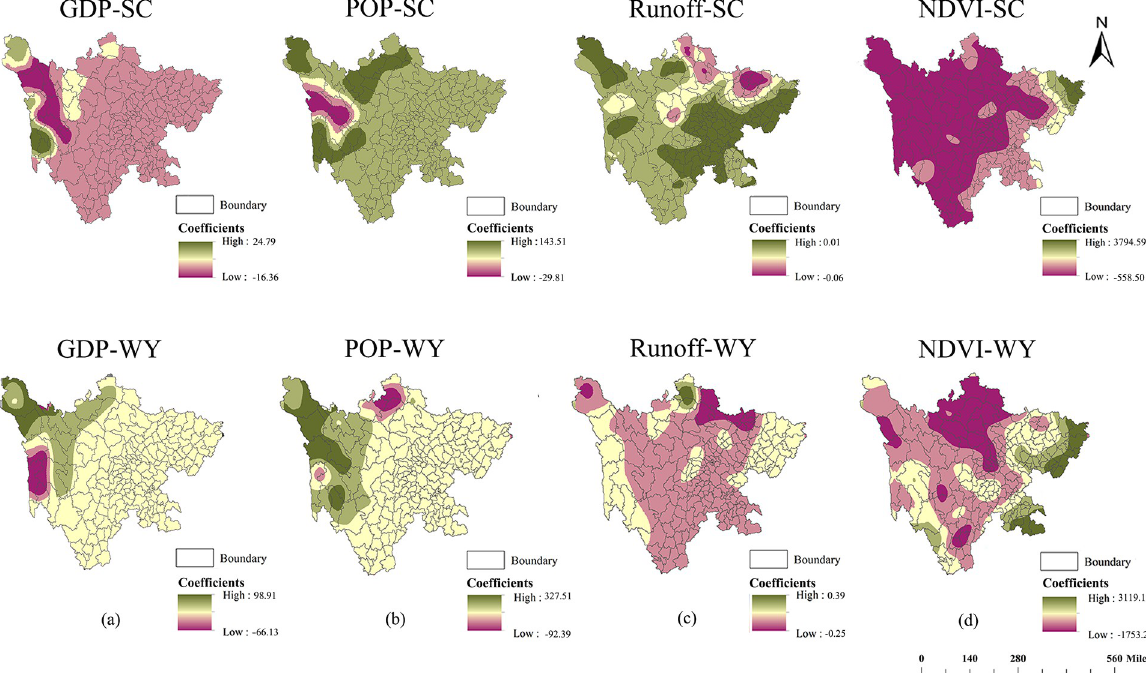
Fig 4. Spatial distribution of local regression coefficients between soil conservation (SC)/water yield (WY) and four drivers: Gross domestic production (GDP), population density (POP), Runoff, and NDVI.